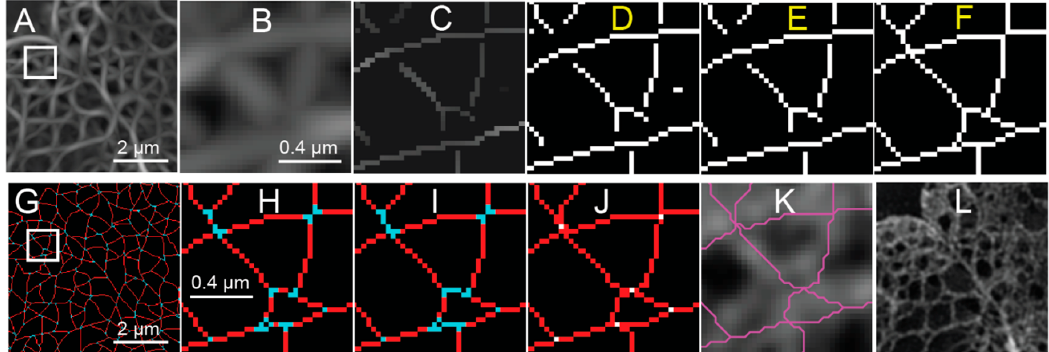
Figure 4. Pixel Based Processing of Steerable Filter Response and Non-Maximum Suppression to Form the Initial Meshwork Structure from a SIM Image of a Lmnb1 − / − MEF. The maximum steerable filter response ( A ) of the area indicated in Figure 1C of a reconstructed image of the Lmnb1 − / − MEF nucleus is shown. The area indicated by white box of (A) is magnified by five times ( B ). Non-maximum suppression (NMS) is then applied ( C ) to the maximum steerable filter response (A). The NMS (C) is then binarized such that non-zero pixels are indicated as white pixels to create a binarized image with line segments ( D ). Short segments of less than five pixels are removed from the binarized skeleton ( E ). The endpoints of line segments are extended until meeting another segment ( F ). Pixels in the extended binarized skeleton (F) for the area shown in Panel A are classified as either morphological edges (red) or branch points (cyan) ( G ). The area indicated by the white box of Panel G is magnified five times ( H ). Short segments between branch points are reclassified (F) as being part of a junction (cyan). The centroids of connected junctions (white) are identified ( J ) and the end points of edges are extended to them using the Bresenham line drawing algorithm (red). Edges are drawn as magenta lines and overlaid on reconstructed image of a reconstructed Lmnb1 − / − MEF ( K ). For comparison, the reconstructed fluorescence intensity image of the same area illustrated in (A) and (G) before processing is shown in ( L ). The white scale bar indicates two micrometers (A, G, L) or 0.4 micrometers (B–F, H–K). The figure has been adapted from portions of Shimi and Kittisopikul et